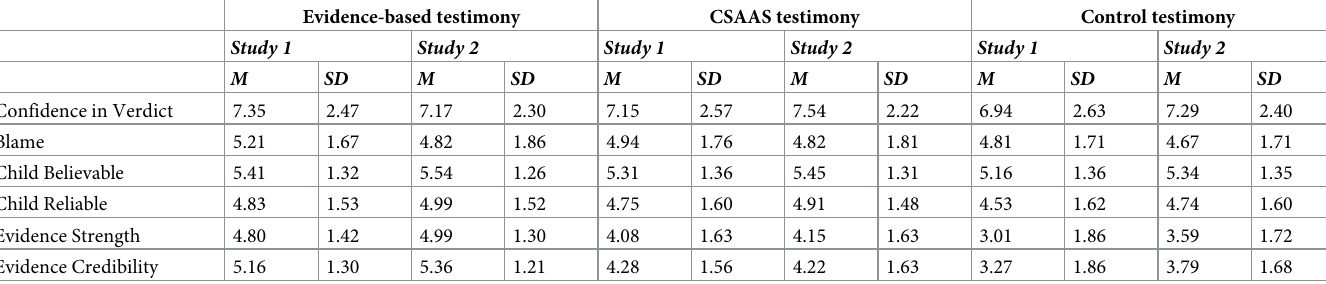
Table 1. Descriptive statistics detailing case perceptions and outcomes by condition in Study 1 and Study